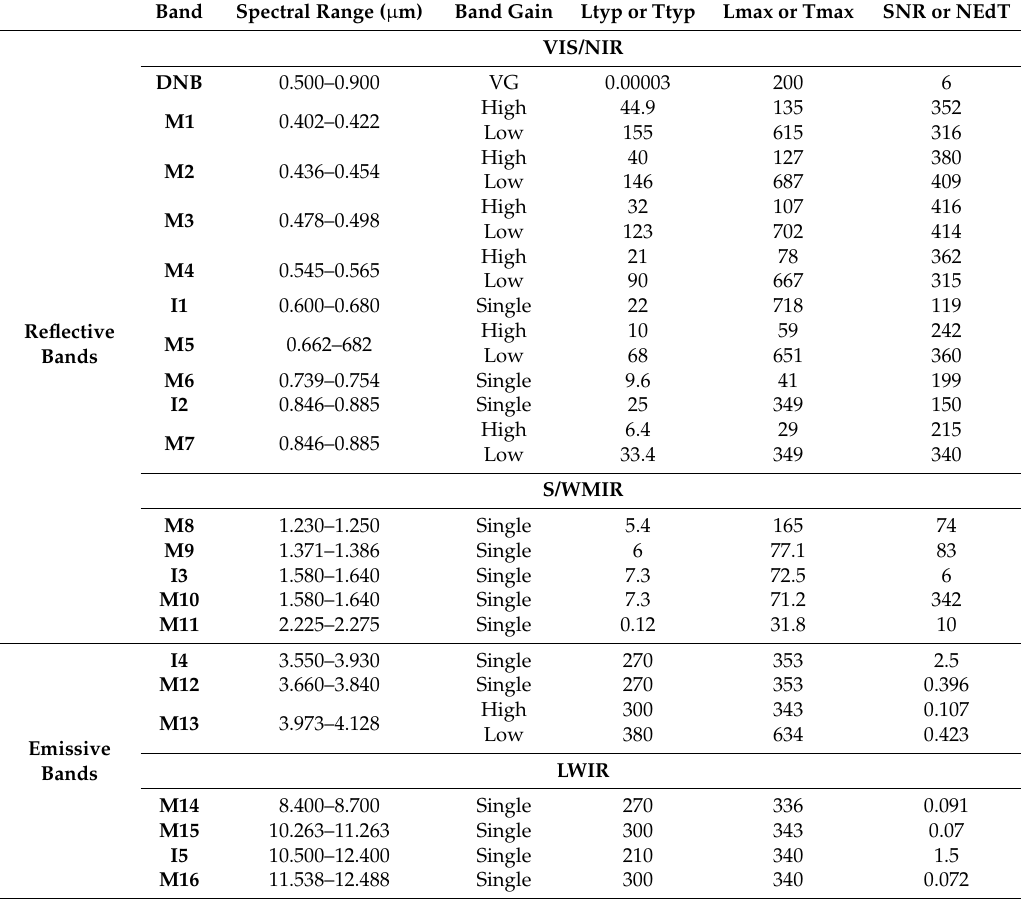
Table 1. VIIRS spectral band design specifications including typical scene readiances or temperatures (Ltyp or Ttyp) and maximum scene radiances or temperatures (Lmax or Tmax). VG denotes variable gain (low gain, middle gain and high gain). Units are Wm ´ 2 ¨ sr ´ 1 ¨ µ m ´ 1 for the RSB and K for the TEB; DNB radiance units are Wm ´ 2 ¨ sr ´ 1 . SNR are listed at Ltyp, and NEdT are listed at Ttyp. M and I indicate moderate and imaging resolution.